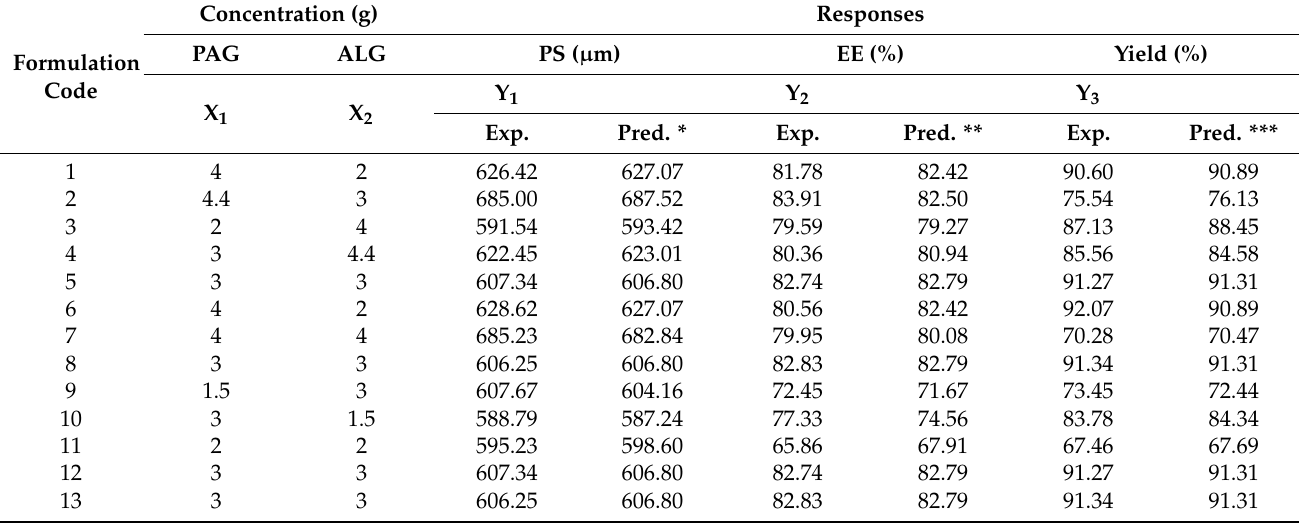
Table 1. Central composite design of two independent factors with actual and predicted values of response